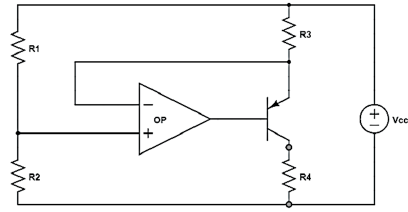
Figure 6. Constant-current circuit diagram.